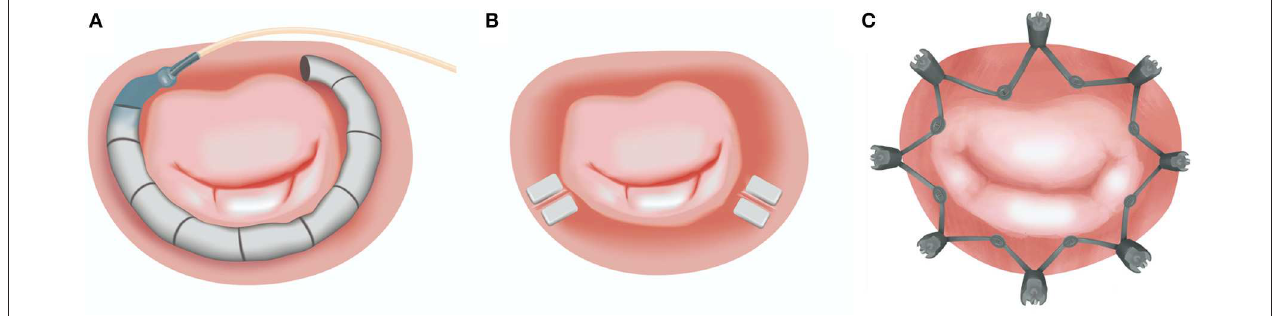
FIGURE 5 | Long-axis view of the LV and MV apparatus. Coaptation length, height, and tenting area are among key measurements in the preoperative planning and screening.